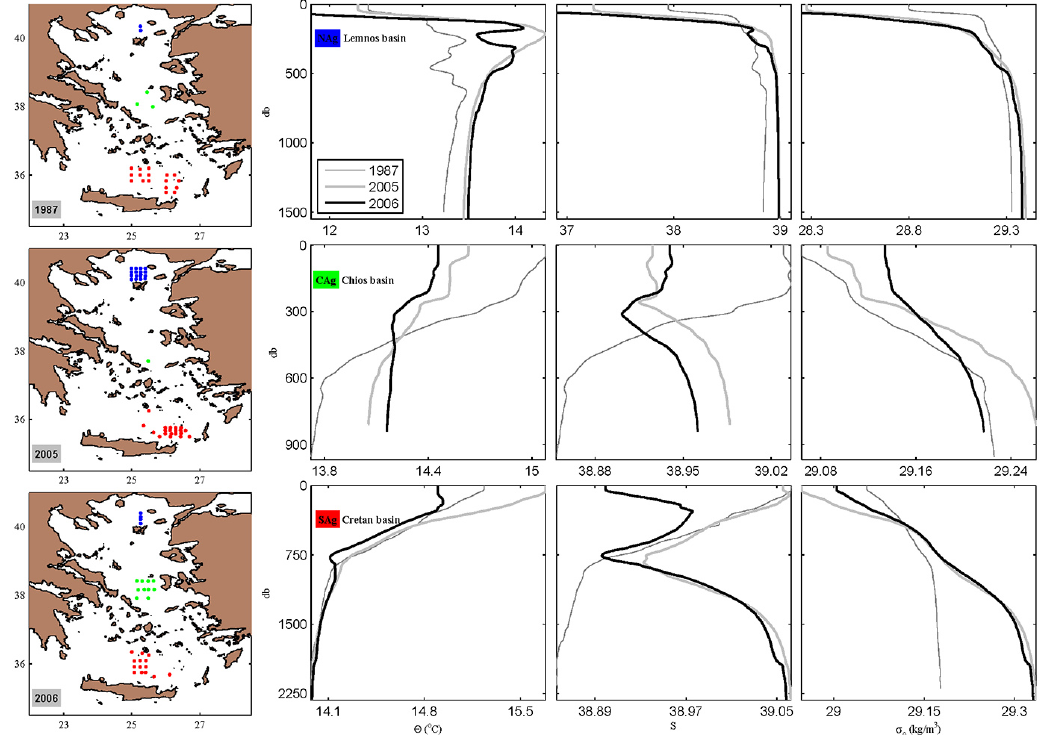
Fig. 14. Map panels: Aegean Sea winter hydrographic stations for the years 1987 (pre-EMT), 2005 and 2006 (post-EMT); North Aegean (NAg): blue dots at the Lemnos basin; Central Aegean (CAg): green dots at the Chios basin; South Aegean (SAg): red dots at the central– eastern Cretan basin. Profile panels: averaged profiles of Q ( ◦ C), S and σ θ (kgm − 3 ) , for all three major sub-basins; adapted from Vervatis et al.